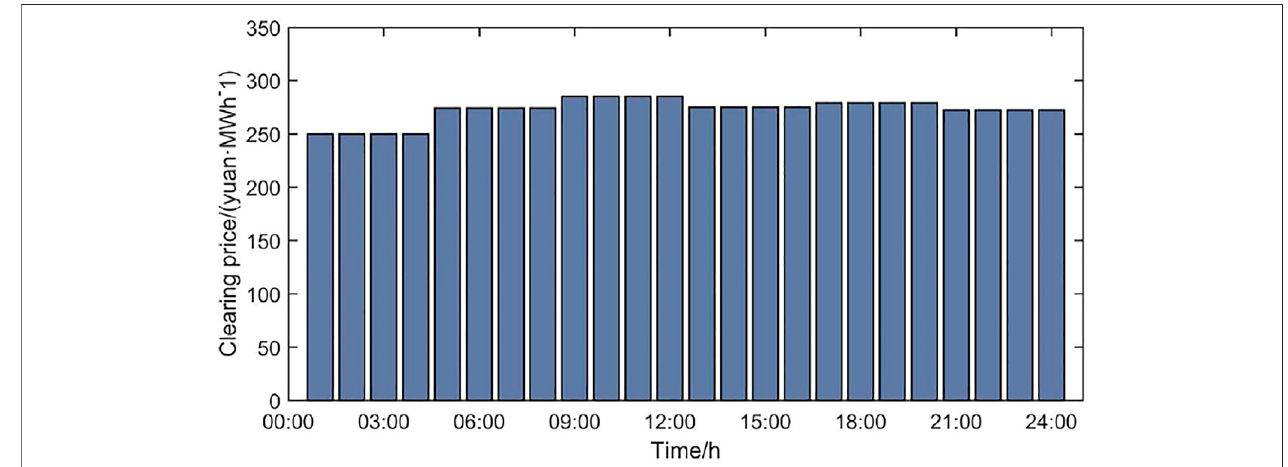
FIGURE 10 | MCP results of the simulation considering 25% wind power